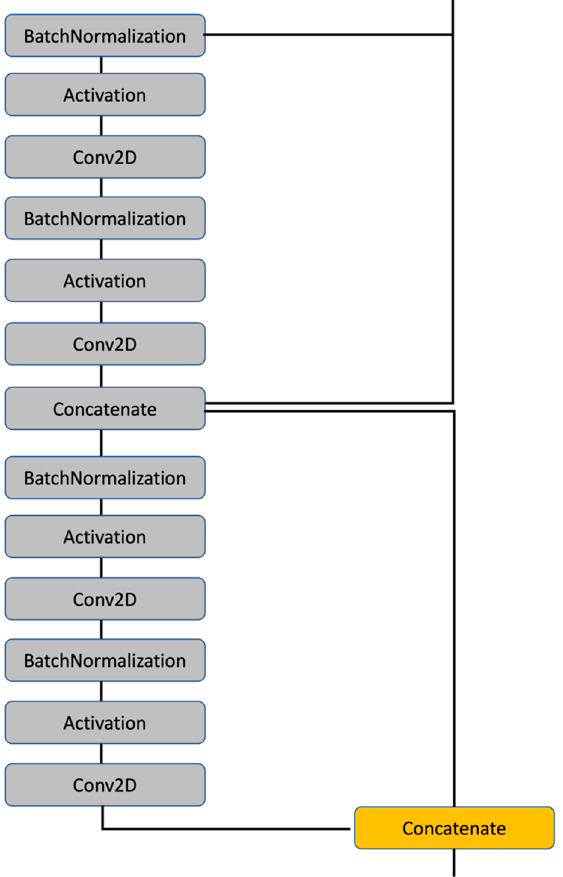
Figure 10. Partial illustration of the DenseNet169 architecture.